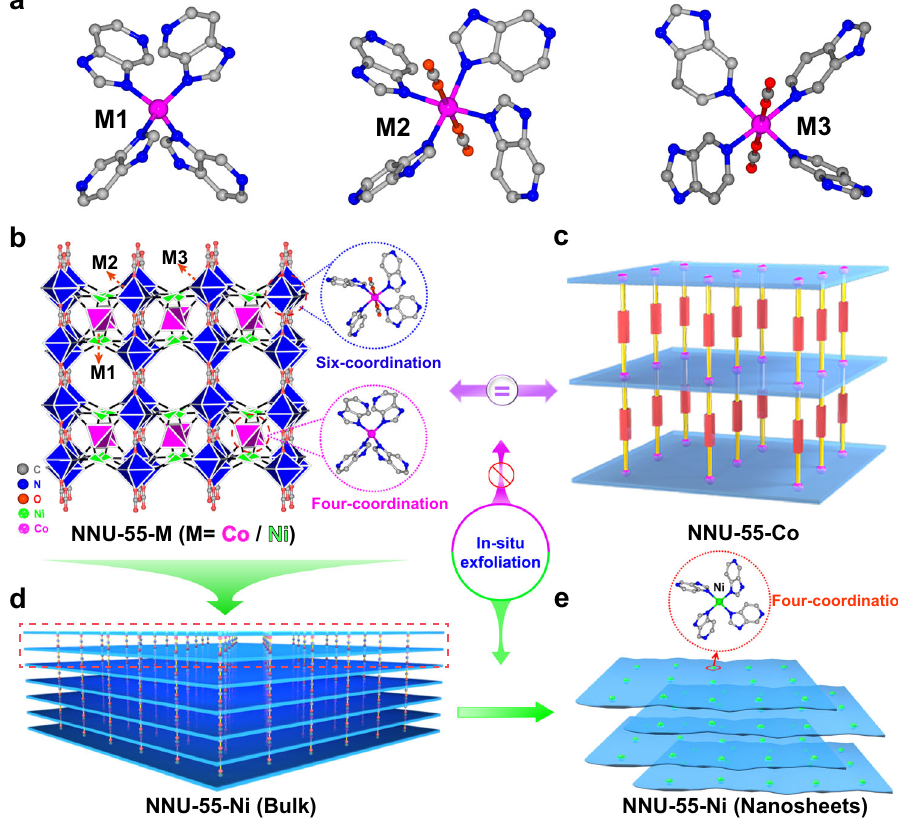
Fig. 2 The crystal structure and in situ exfoliation process of NNU-55-M. a The coordination environments of three crystallographic independent M atoms (M1/M2/M3). b The three-dimensional framework and metal coordination environment of NNU-55-M (M = Co/Ni). c Schematic diagram of crystal structure to NNU-55-Co is corresponding to b . It shows that no such in situ exfoliation occurs to NNU-55-Co. d The schematic illustration of NNU-55-Ni (Bulk) shows the pillar-layer structure. The red dashed region is equated to b . e NNU-55-Ni (Bulk) experienced an in situ exfoliation process, NNU-55-Ni (Nanosheets) were